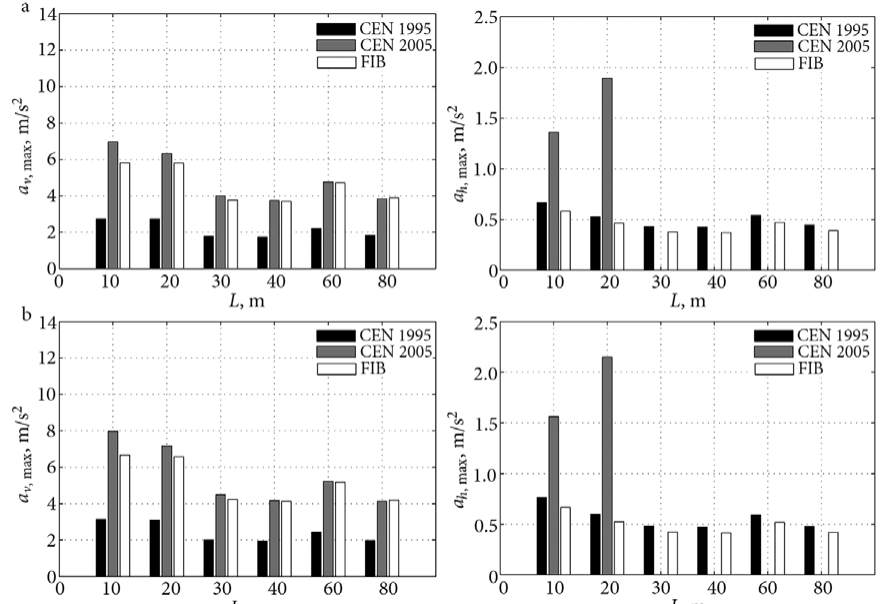
Fig. 8. Vertical and lateral accelerations induced by a flow of 0.6 walkers/m 2 : comparison between the response with (a) and without (b) mass of the walkers Table 3. Vibration frequency variation due to the mass of the walkers (footbridges without concrete slab) Mass Density δ, variation,